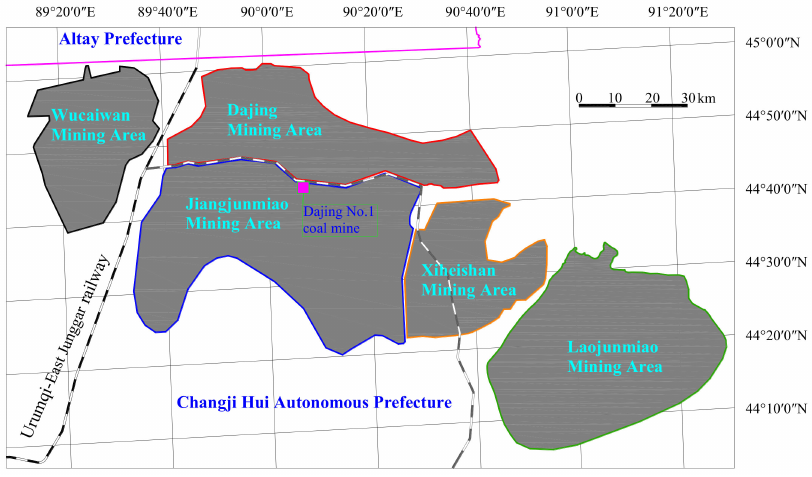
Figure 1. Locations of the main coal mines in East Junggar